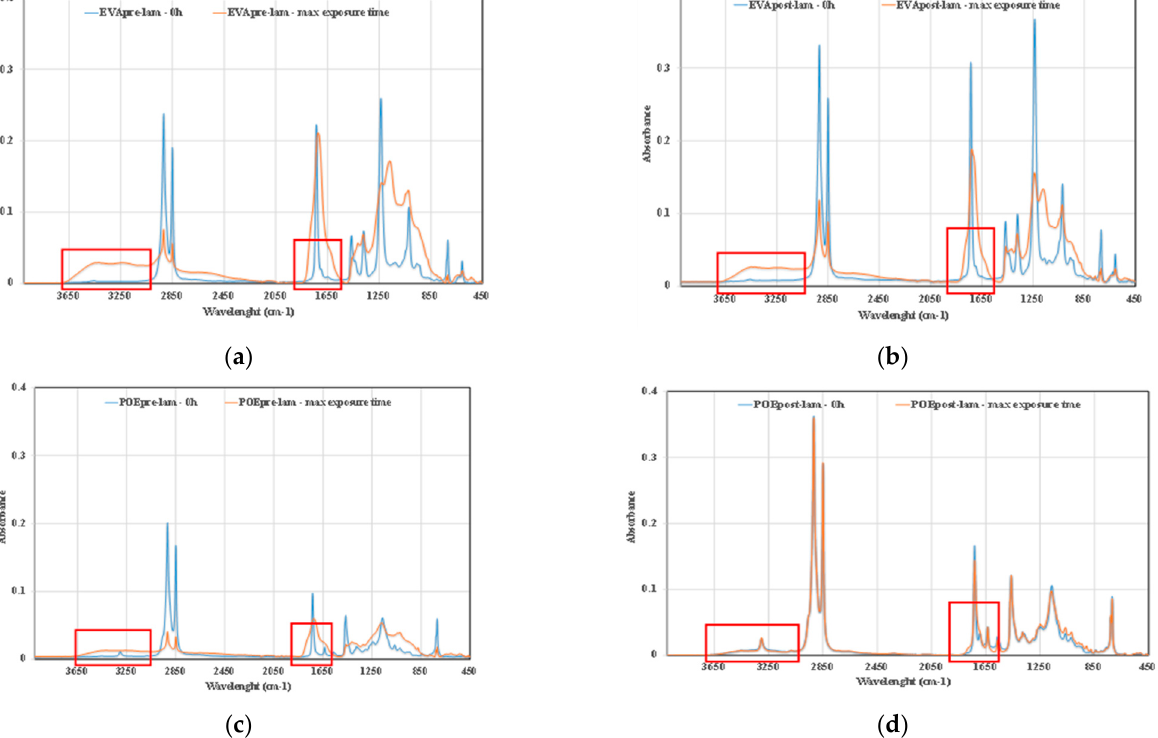
Figure 9. ATR-FTIR spectra of ( a ) EVApre-lam, ( b ) EVApost-lam, ( c ) POEpre-lam and ( d ) POEpost-lam commercial samples, before exposure and at maximum UVB exposure time.